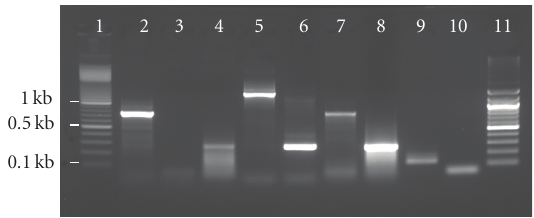
Figure 1: PCR results from water extracts used for various methods. Lane 1: 100 bp DNA ladder, Lane 2: B.